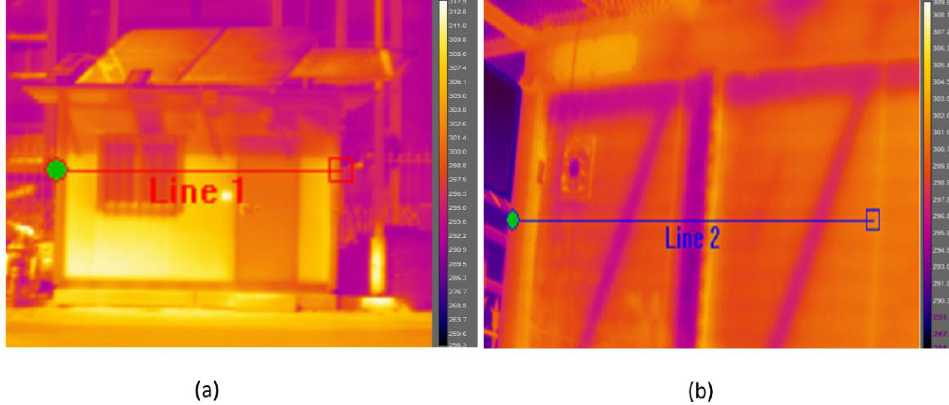
Figure 14. Temperature distribution using thermography: ( a ) front wall; ( b ) left wall.